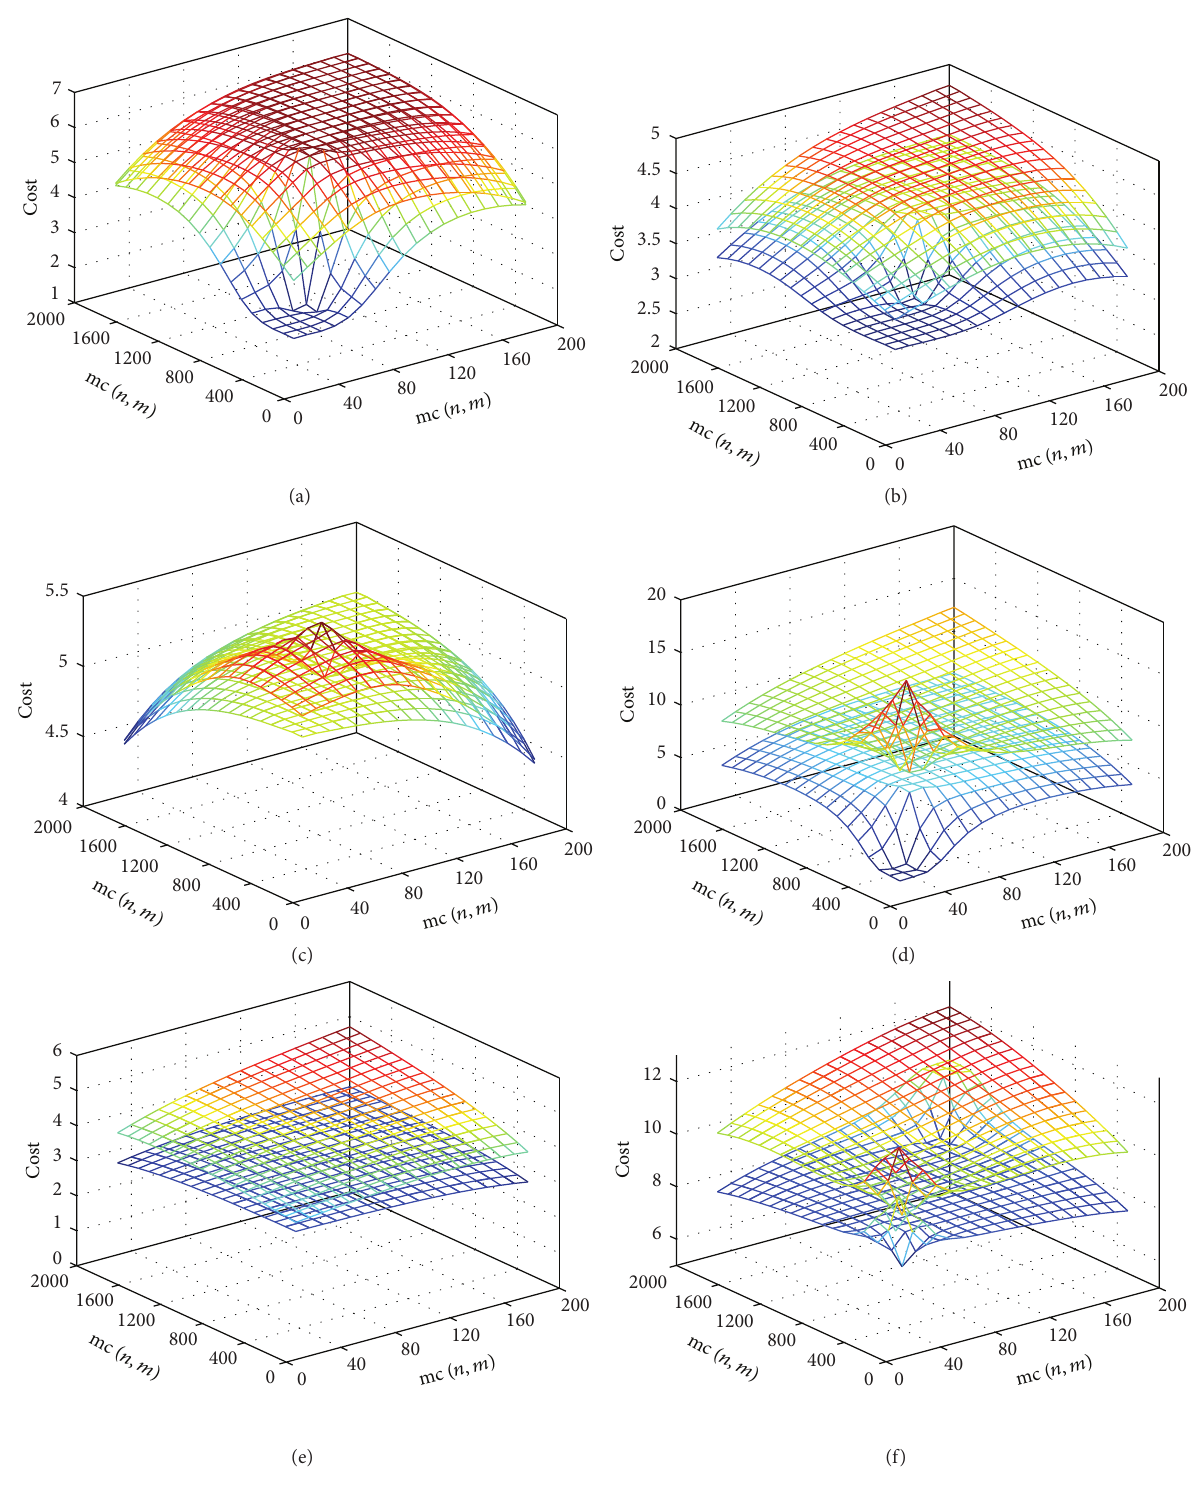
Figure 4: Test cost and average total cost: (a) Liver ; (b) Wdbc ; (c) Wpbc ; (d) Diab ; (e) Iono ; (f) Credit